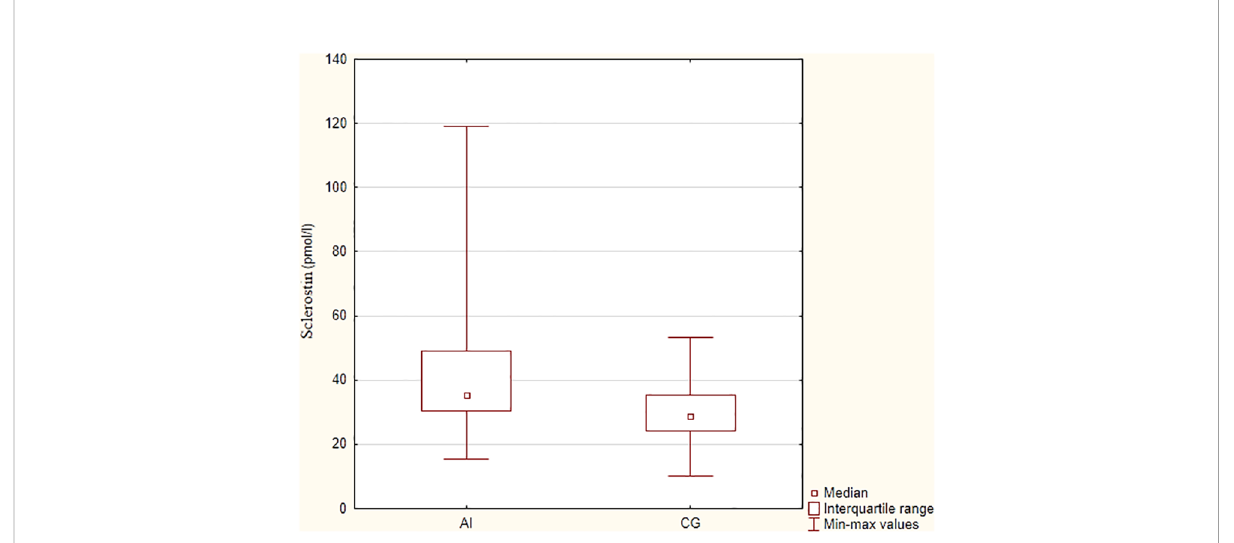
FIGURE 2 Sclerostin concentrations in patients with primary adrenal insuf fi ciency and control group. AI – adrenal insuf fi ciency group, CG – control group.